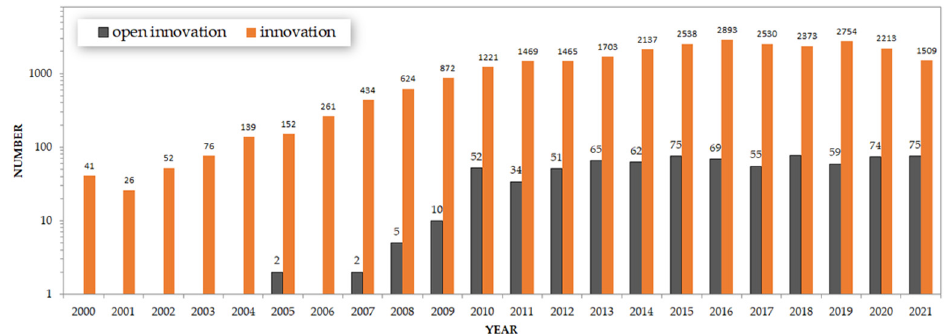
Figure 2. The number of publications appearing annually in scientific periodicals indexed in the Russian Science Citation Index in 2000–2021. Search was performed with “open innovation” and ‘’innovation”